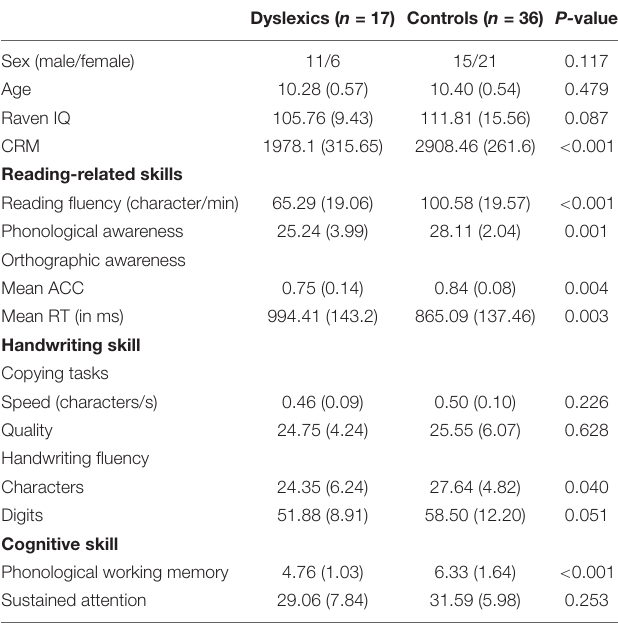
TABLE 1 | Demographic information of the participants and behavioral